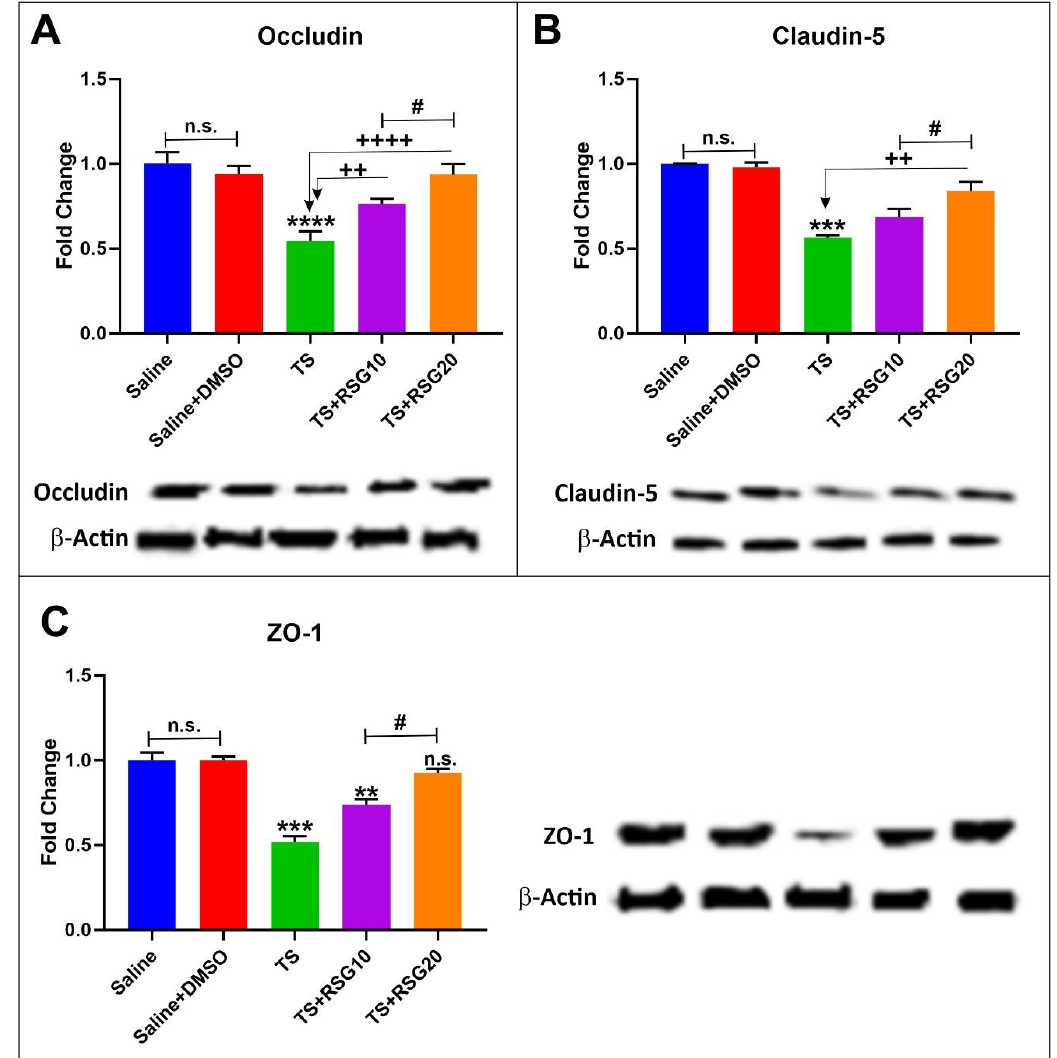
Figure 4. Dose-dependent protective e ff ects of RSG against TS-induced loss of barrier integrity. Western blotting analysis demonstrating downregulation of TJ proteins ZO-1 ( A ), occludin ( B ) and claudin-5 ( C ) in animals exposed to TS. The e ff ect was mitigated by RSG treatment in a dose-dependent manner. n = 4 biological replicates. * p < 0.05, ** p < 0.01, *** p < 0.001 versus saline. + p < 0.05; ++ p < 0.01 versus TS. # p < 0.05 TS + RSG 20 versus TS + RSG 10. WB analyses reported protein / β -actin ratios. n.s. = non statistical significance. n = 4 biological